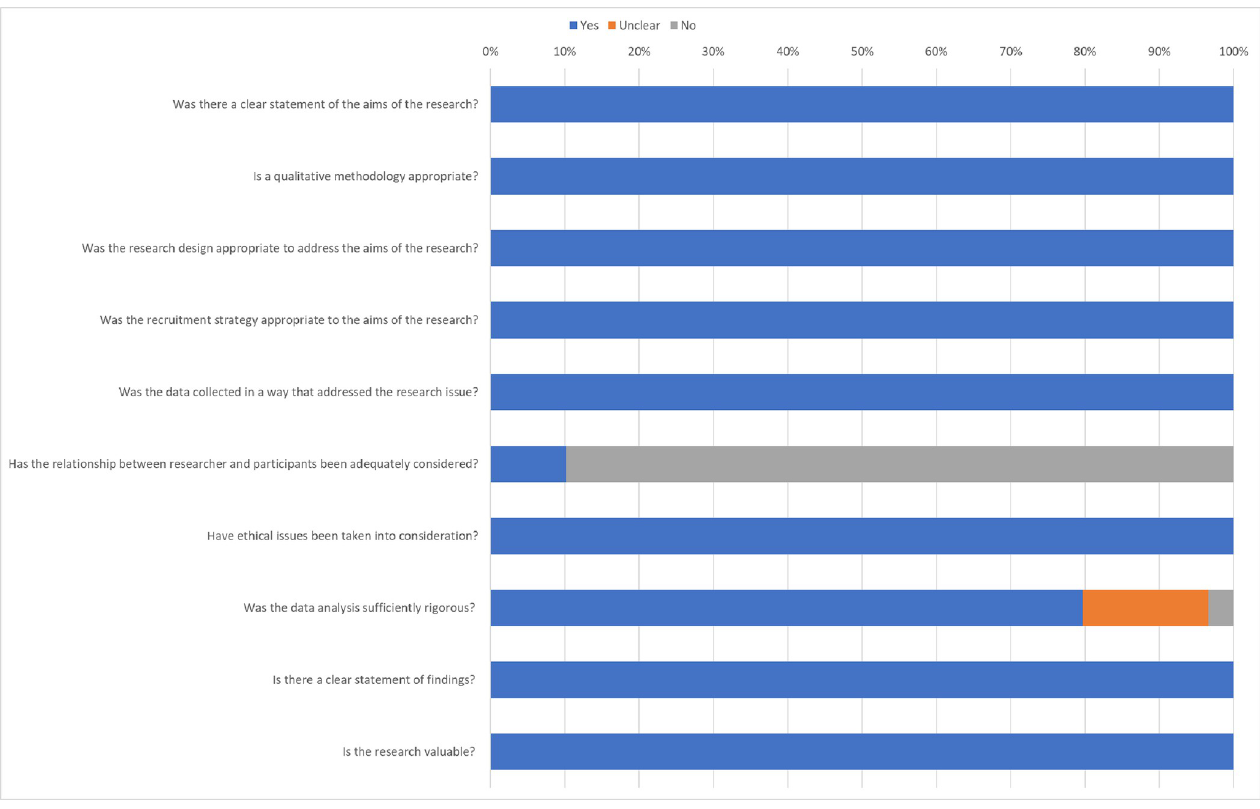
Fig 2. Critical Appraisal Skills Program CASP evaluation summary for included